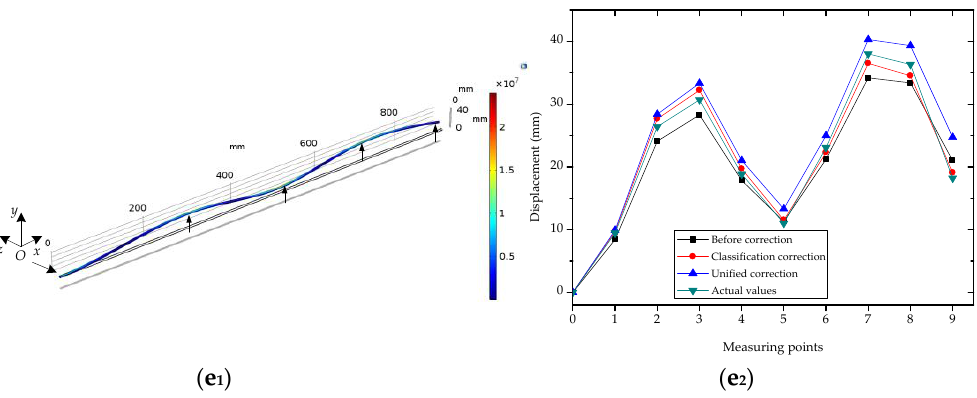
Figure 9. The simulation diagram of the bending shapes of the FBG implantable flexible morphological sensor under different loading modes and displacement at measuring points were obtained based on the arc curve fitting algorithm. ( a 1 ) Simulation of applying force at the end of the model. ( a 2 ) Displacement comparison of measuring points at Type 1. ( b 1 ) Simulation of applying force at the middle of the model. ( b 2 ) Displacement comparison of measuring points at Type 2. ( c 1 ) Simulation of applying force at two points of the model. ( c 2 ) Displacement comparison of measuring points at Type 3. ( d 1 ) Simulation of applying force at three points of the model. ( d 2 ) Displacement comparison of measuring points at Type 4. ( e 1 ) Simulation of applying force at four points of the model. ( e 2 ) Displacement comparison of measuring points at Type 5.